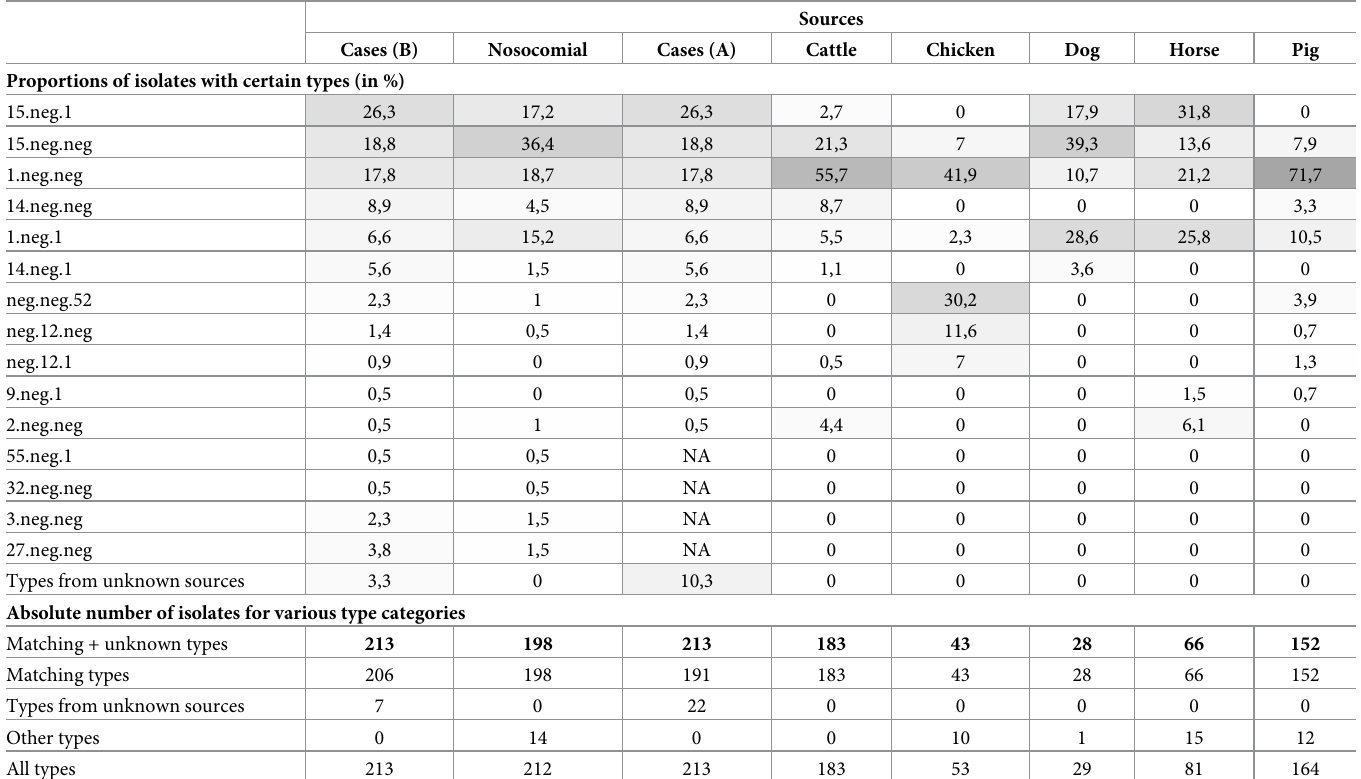
Table 3. Number of matching, unknown and other types for Set A1 and